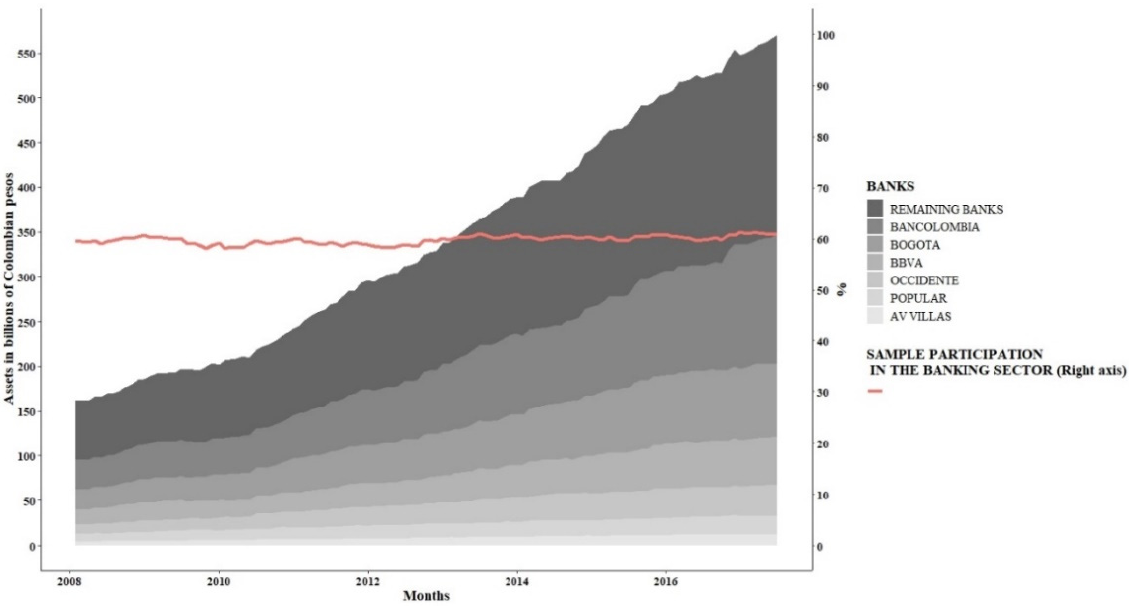
Figure 1. Participation in the level of assets of the selected sample on the sector. Source: Owner.